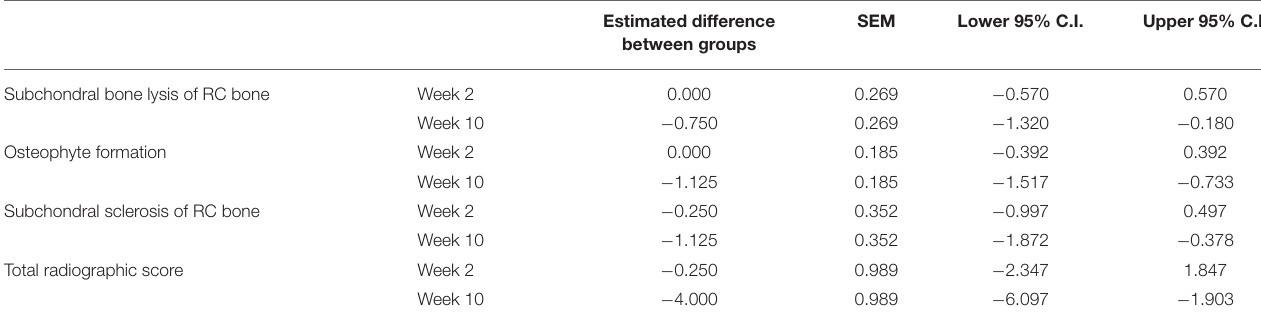
TABLE 1 | Means and estimates of variance for radiographic parameters that demonstrated a significant difference between the BO-treated and placebo-treated horses when evaluating a difference from baseline.